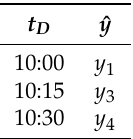
Table 3. Result nearest join.